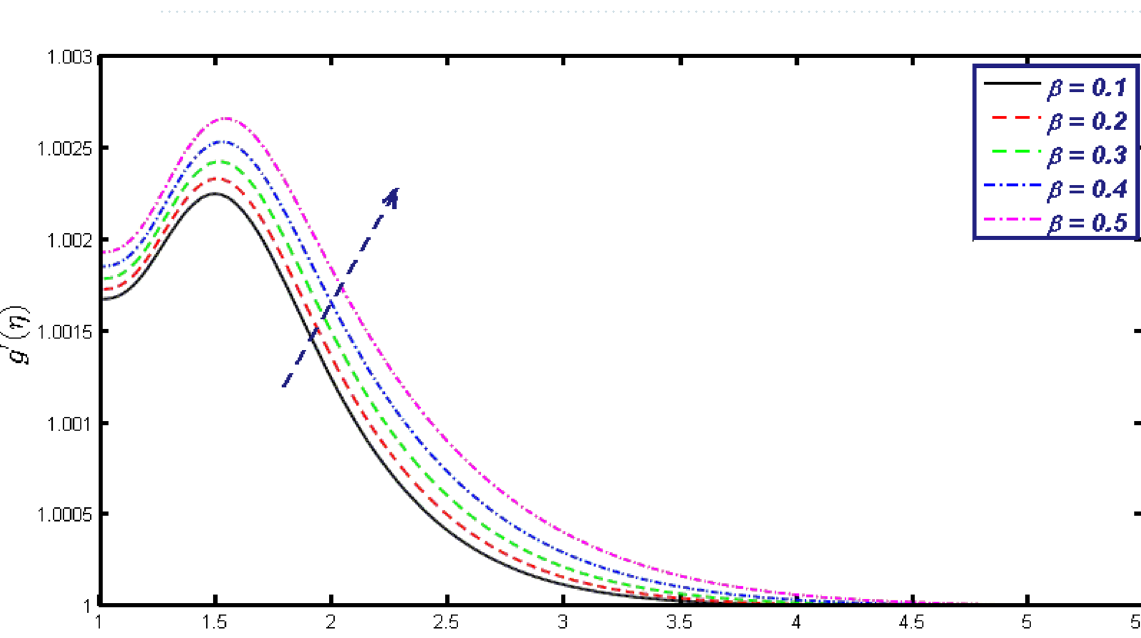
Figure 15. g ′ (η) field for distinct values of α 1 .